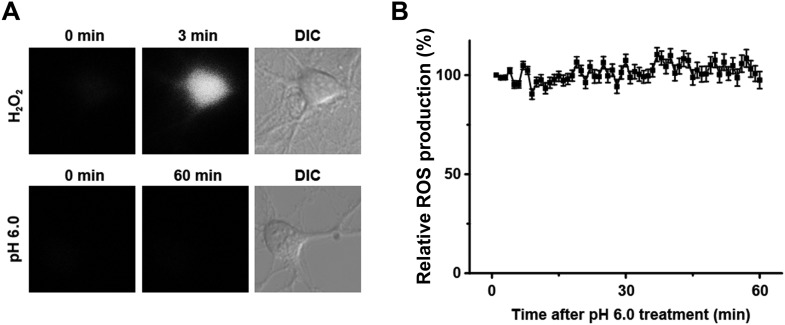
Acid (pH 6.0) treatment does not induce reactive oxygen species (ROS) production in cultured mouse cortical neurons.(A) H2O2 but not the pH 6.0 solution caused a rapid increase in intracellular ROS (stained with CM-H2DCFDA). (B) No change in the ROS level was observed during 1 hr treatment with the pH 6.0 solution (n=25).